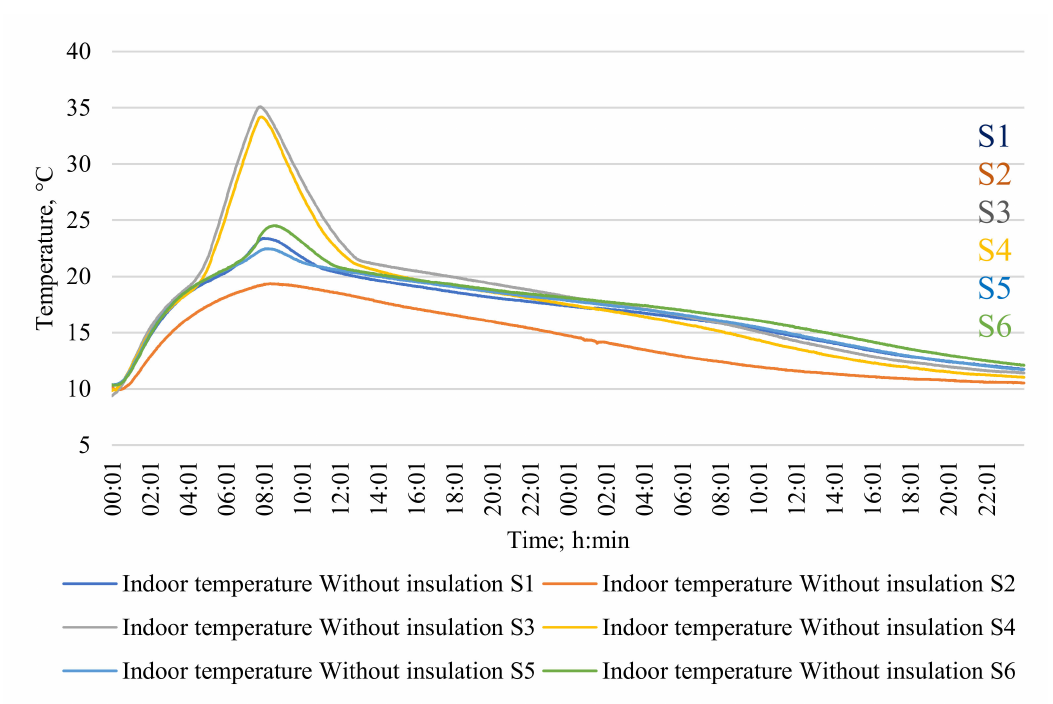
Figure 10. The average temperature in phase-change material in six setups with insulation applied at night.